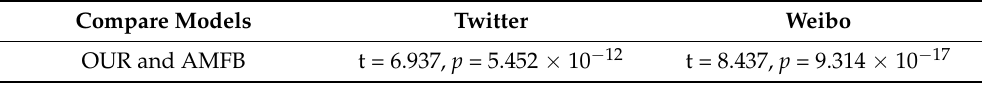
Table 8. The results of t